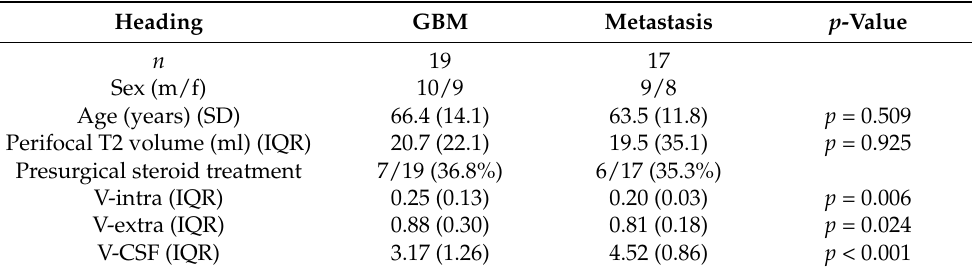
Figure 4. Normalized perilesional (T2) diffusion microstructure imaging (DMI) metrics in patients with GBM ( n = 19) and metastases ( n = 17), normalized to whole ‐ brain normal ‐ appearing white mat ‐ ter (NAWM) values. Compared to GBM, metastases show a significant shift towards increased